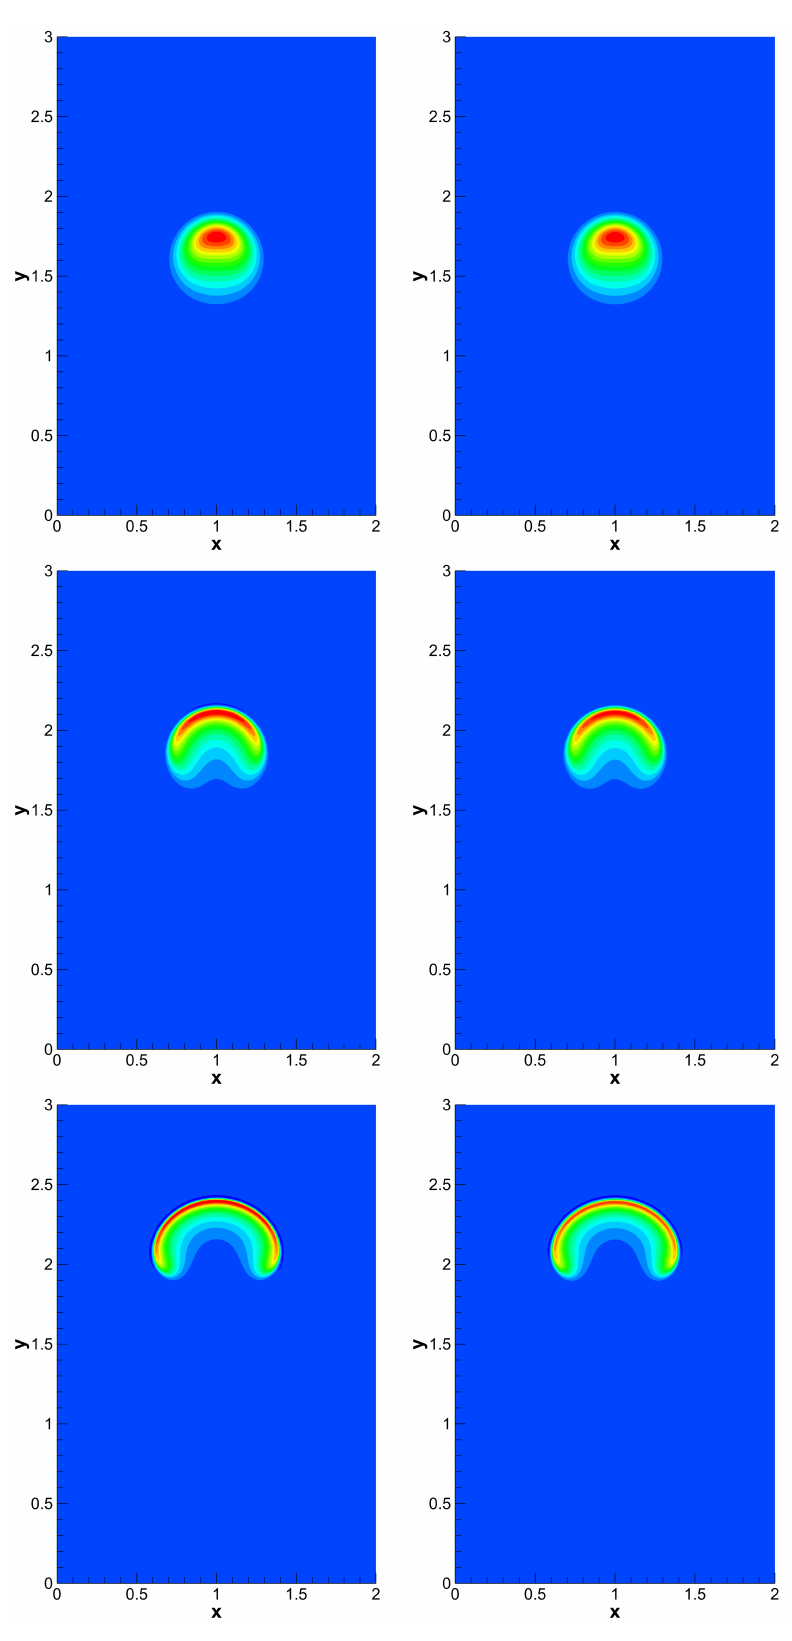
Figure 15. Comparison of the temperature field obtained using the weakly compressible scheme ( left ) and the all Mach number solver. From top to bottom : t = 0.5, t = 1, t =